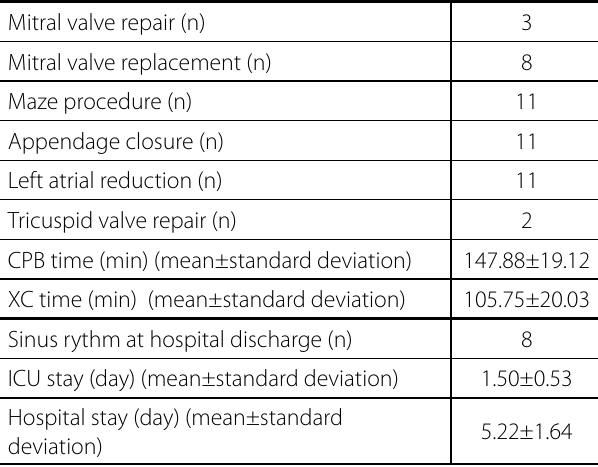
Table 5 . Operative and postoperative